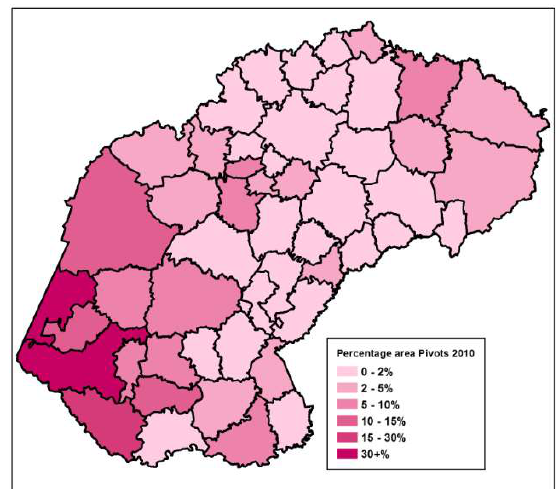
Figure 29. The percentage of all cultivated fields that are pivot irrigated per district for Freestate in